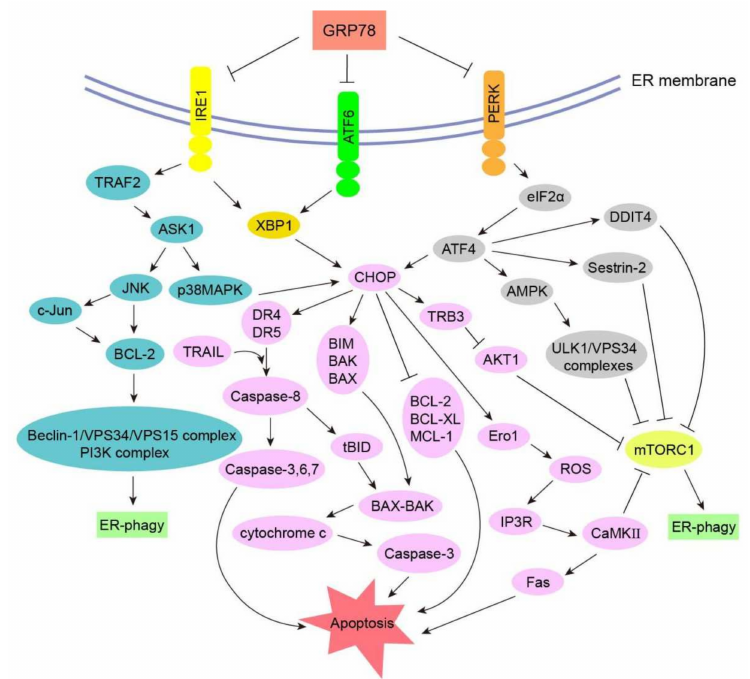
Figure 2. Molecular mechanism of the unfolded protein response and ER-phagy. Under normal physiological conditions, GRP78 can inhibit the activity of IRE1, ATF6, and PERK. Under ER stress, the misfolded proteins can lead to their dissociation from GRP78 and trigger downstream signal propagation. IRE1 interacts with TRAF2 and generates XBP1s, then prompts ER-phagy through the JNK and p38MAPK pathways. ATF6 is transported to the Golgi apparatus and is cleaved to form XBP1s, thus regulating CHOP and its downstream targets, such as the BCL-2 protein family and Caspase signal transduction, resulting in the aggravation of ER-phagy and cell apoptosis. PERK can phosphorylate eIF2 α to inhibit protein synthesis, while ATF4 containing short open reading frames is increased and facilitates CHOP, AMPK, Sestrin-2, and DDIT4 to regulate ER-phagy and